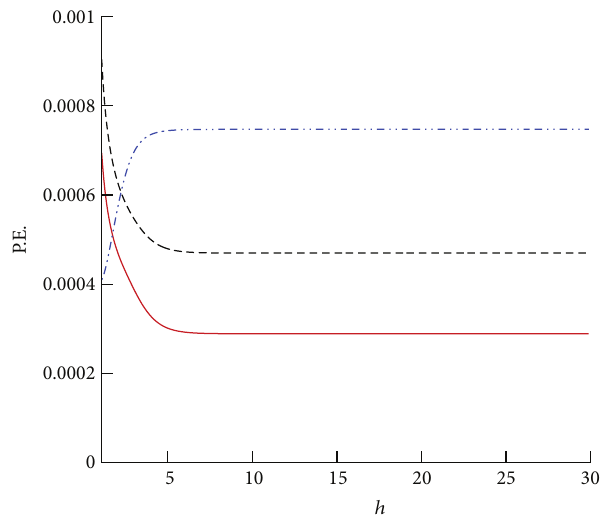
Figure 4: P.E. for (44) versus the water depth ℎ for different Young’s moduli of the plate 𝐸 . Solid line: 𝐸 = 10 8 ; dashed line: 𝐸 = 10 9 ; dash-dot-dotted line: 𝐸 = 10 10 .